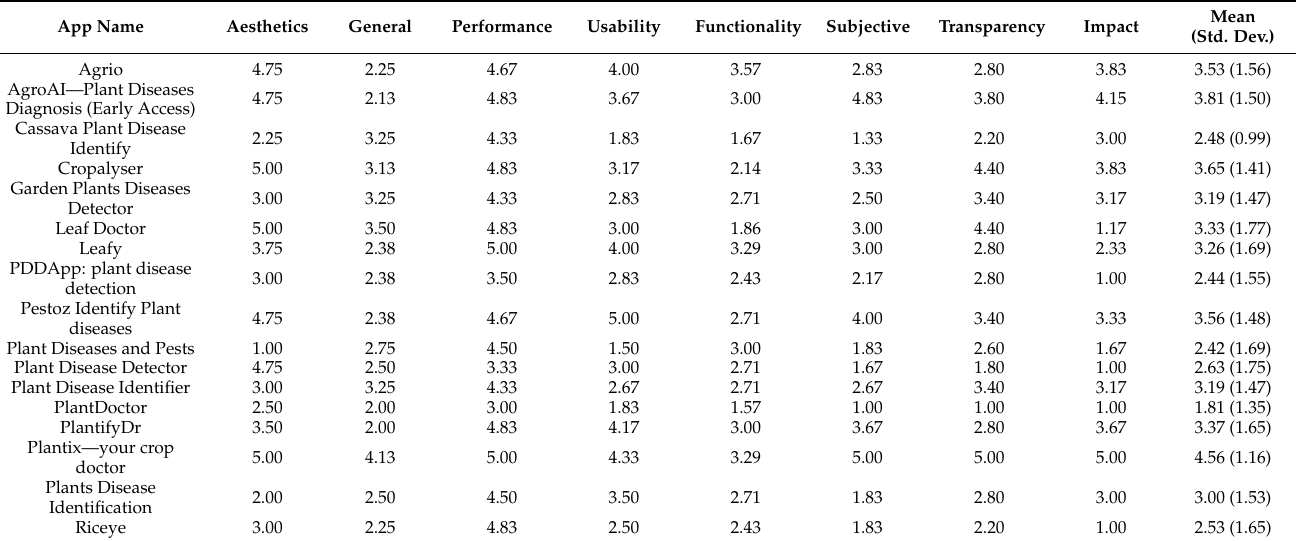
Table 4. Assessment scores for plant disease detection